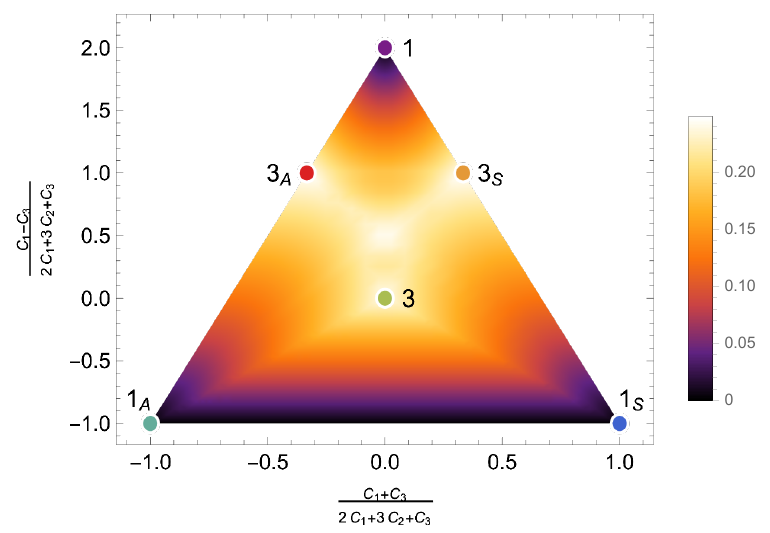
Figure 11. A cross section of the positivity cone in the space of ~C = ( C 1 , C 2 , C 3 ) , defined by the intersection of the hyperplane 2 C on this intersection, as defined in eq. (5.23). The color dots represent the six